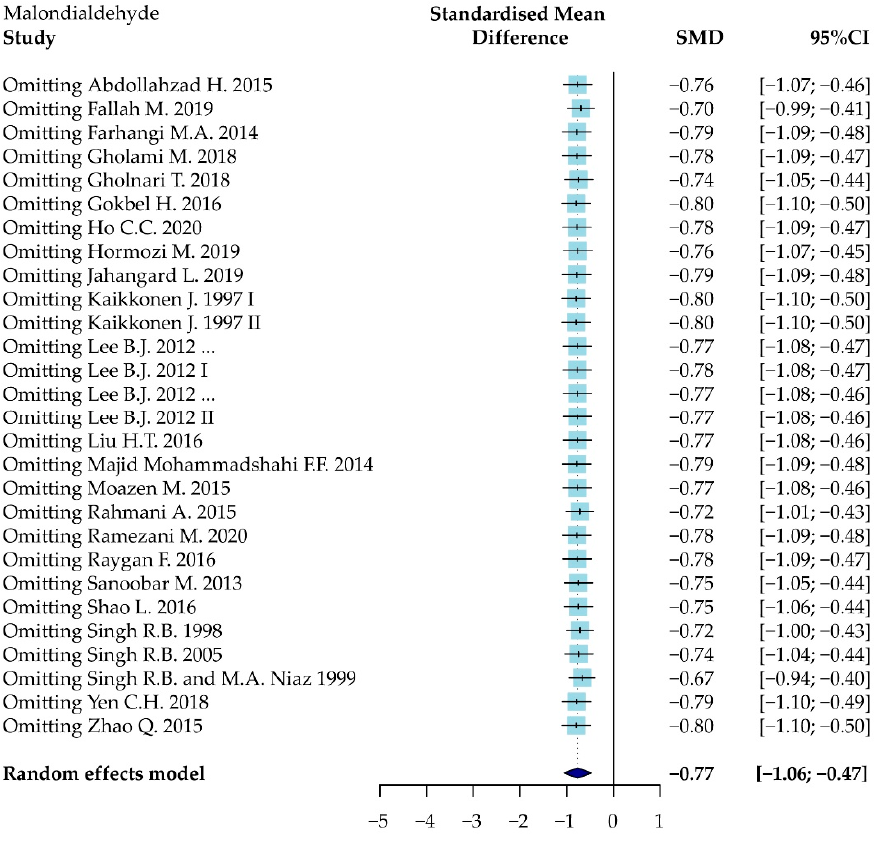
Figure A3. Sensitivity analysis for the effects of CoQ10 on MDA through removal of individual trials one by one.